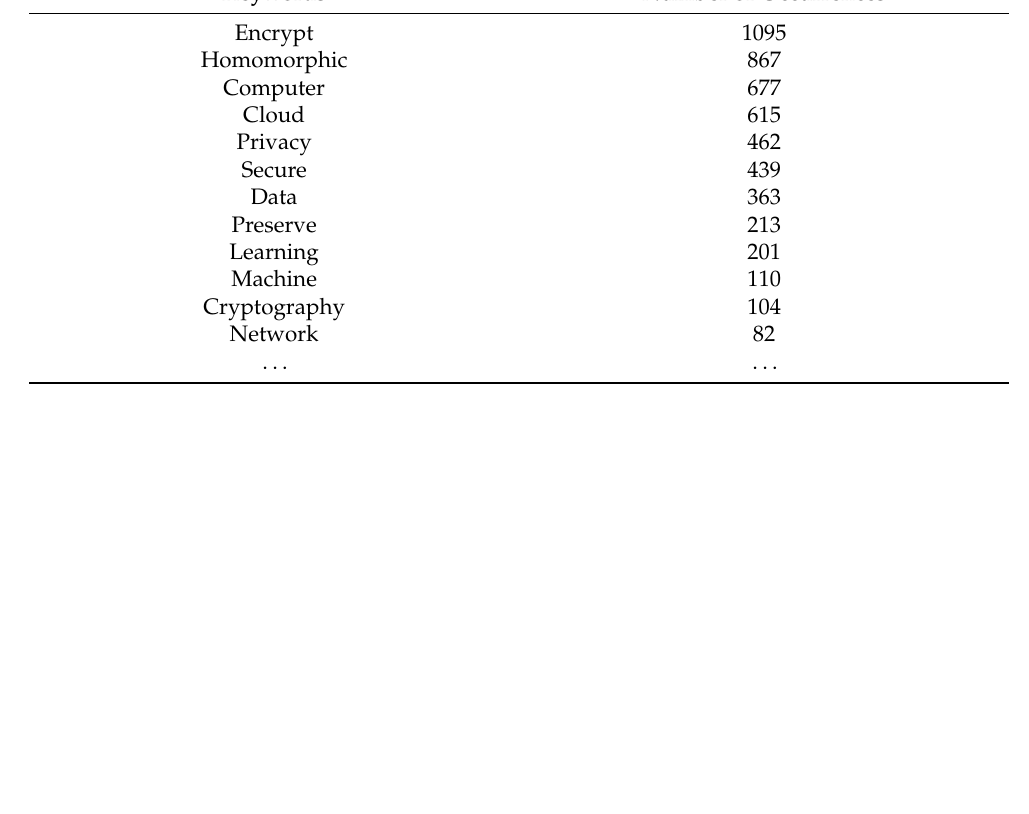
Table 7. Statistics of some keywords.